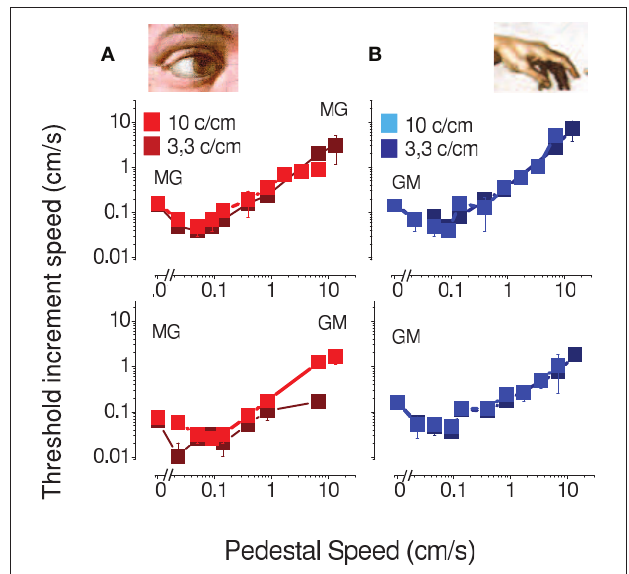
Figure 3 | Speed thresholds in the within modality facilitation condition. (A) Vision only condition. The spatial frequency of 3.3 cycles/cm is reported light red and the spatial frequency of 10 cycles/cm dark red. (B) Tactile only condition. The spatial frequency of 3.3 cycles/cm is reported light blue and the spatial frequency of 10 cycles/cm dark blue. This measure was replicated in